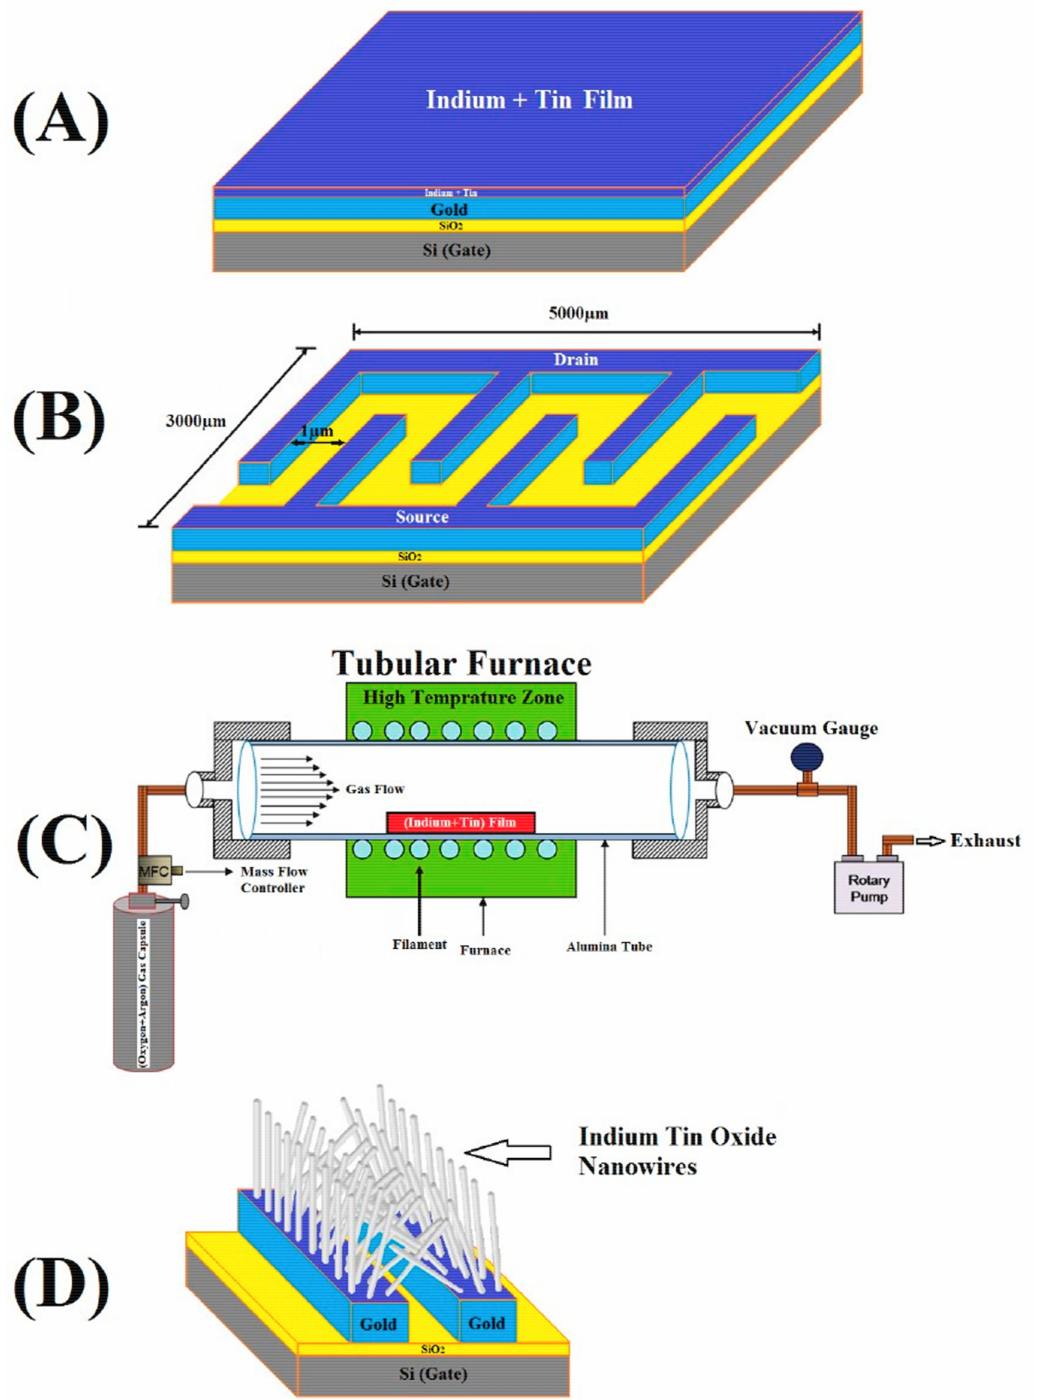
Figure 2. Indium-tin oxide nanowires (ITO-NW) FETs were fabricated by ( A ) coating indium and tin film onto gold film and ( B ) defining pattern of the devices by E-beam lithography before ( C ) treating them with controlled parameters in tubular furnace to ( D ) form ITO nanowires [66]. Reprinted from Biosensors and Bioelectronics, 105, Shariati, The Field E ff ect Transistor DNA Biosensor Based on ITO Nanowires in Label-Free Hepatitis B Virus Detecting Compatible with CMOS Technology, 58–64, Copyright 2018, with permission from